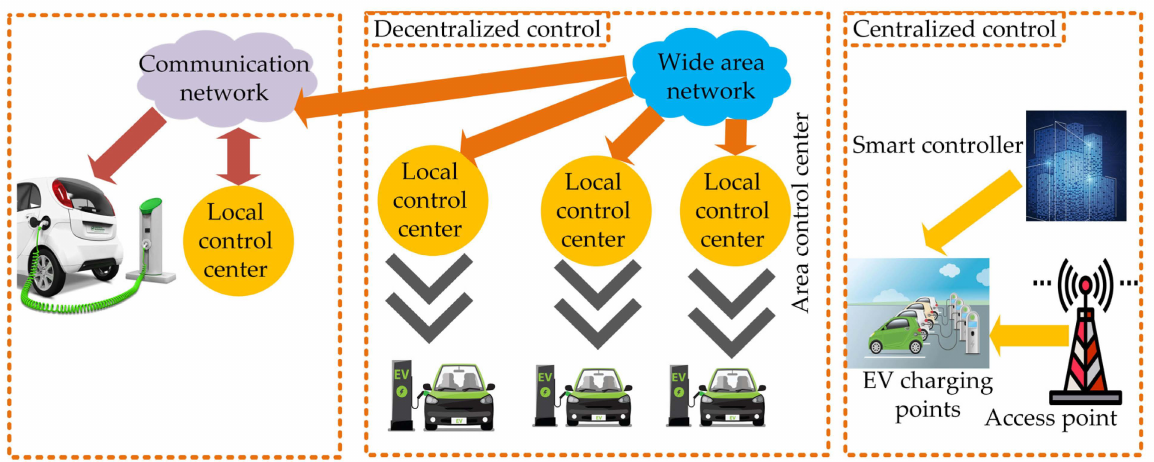
Figure 13. An example of an EV charging system with Centralized control and decentralized